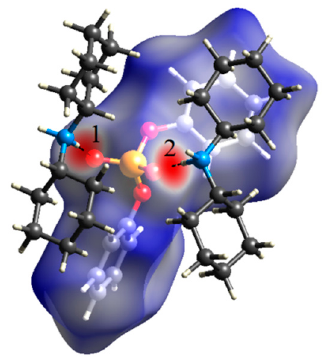
Figure 9. A view of the Hirshfeld surface map of the [(C 6 H 5 O) 2 P(O)(O)] − anion. The interactions according to the labels are as follows, with the labels in parentheses: N1–HN1B…O1 (1) and N1– HN1A…O2 (2). The ball-and-stick models of the anion and two hydrogen-bonded cations are given inside and outside the surface, respectively.